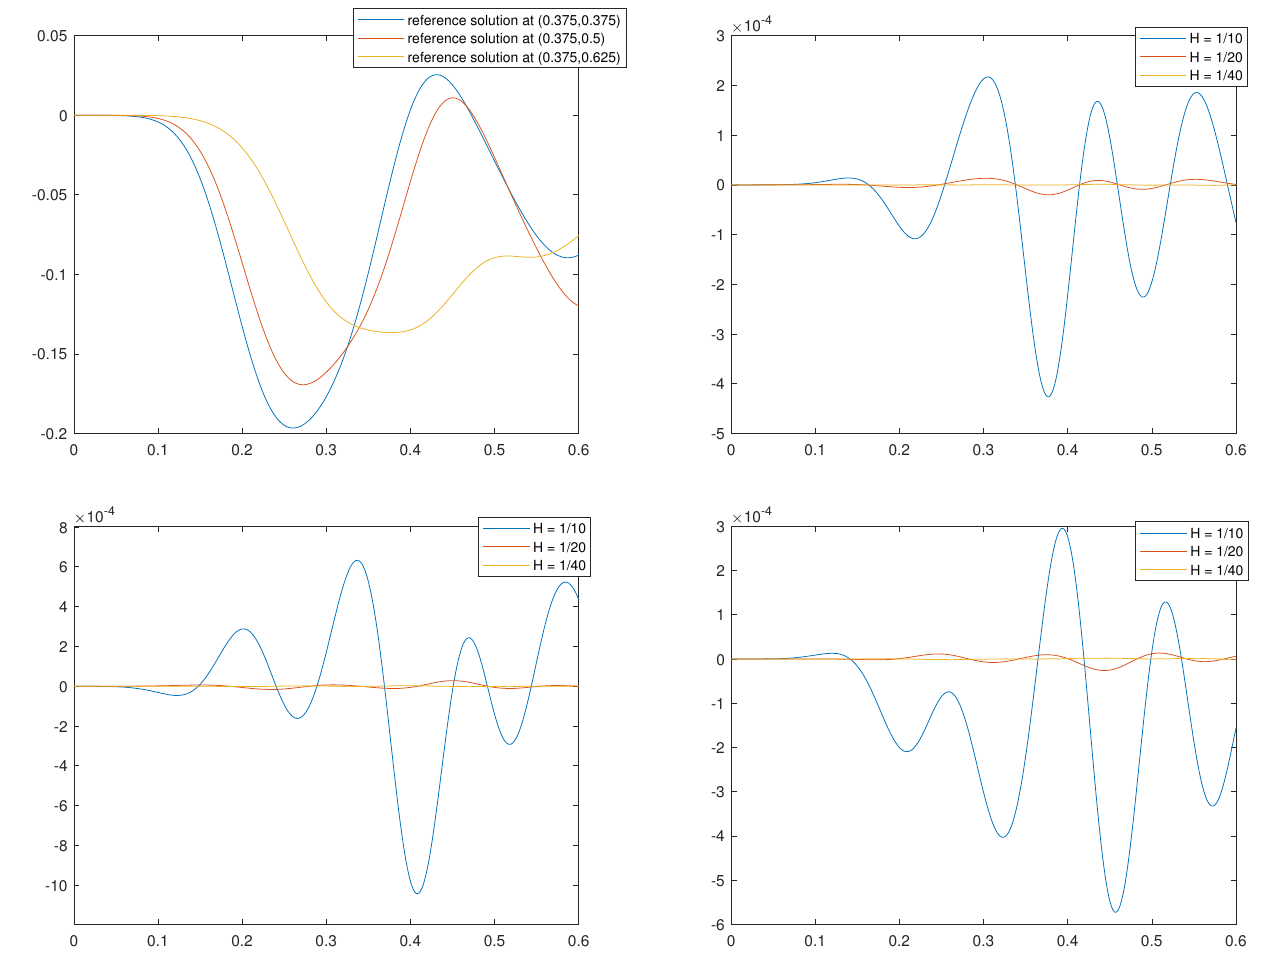
Figure 8. Top-Left : Reference solution at different location. Top-Right : Error of the Partially Explicit scheme at location ( 0.375,0.375 ) . Bottom-Left : Error of the Partially Explicit scheme at location ( 0.5,0.375 ) . Bottom-Right : Error of the Partially Explicit scheme at location ( 0.625,0.375 )